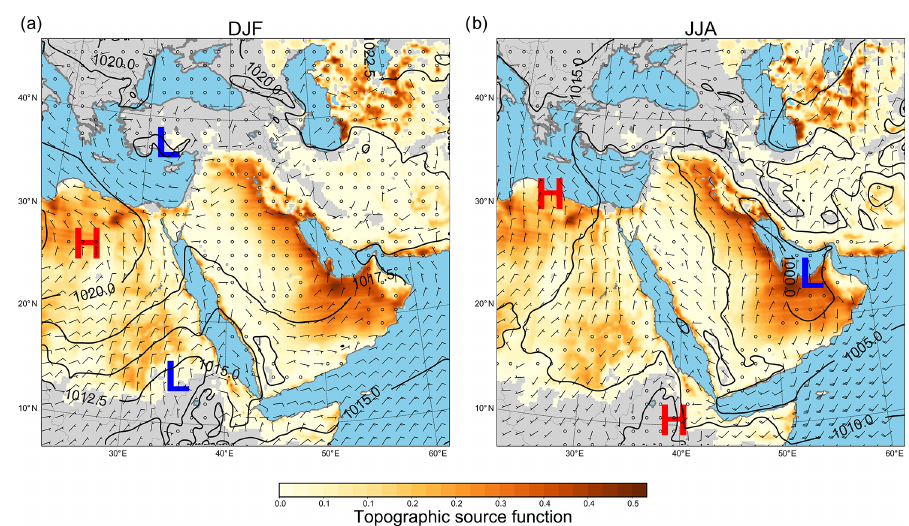
Figure 2. Seasonally averaged (2015–2016) wind barbs (ms − 1 ) at 10m, sea level pressure (contours), and erodibility function (shading; Ginoux et al., 2001). (a) Winter (DJF), (b) Summer (JJA).